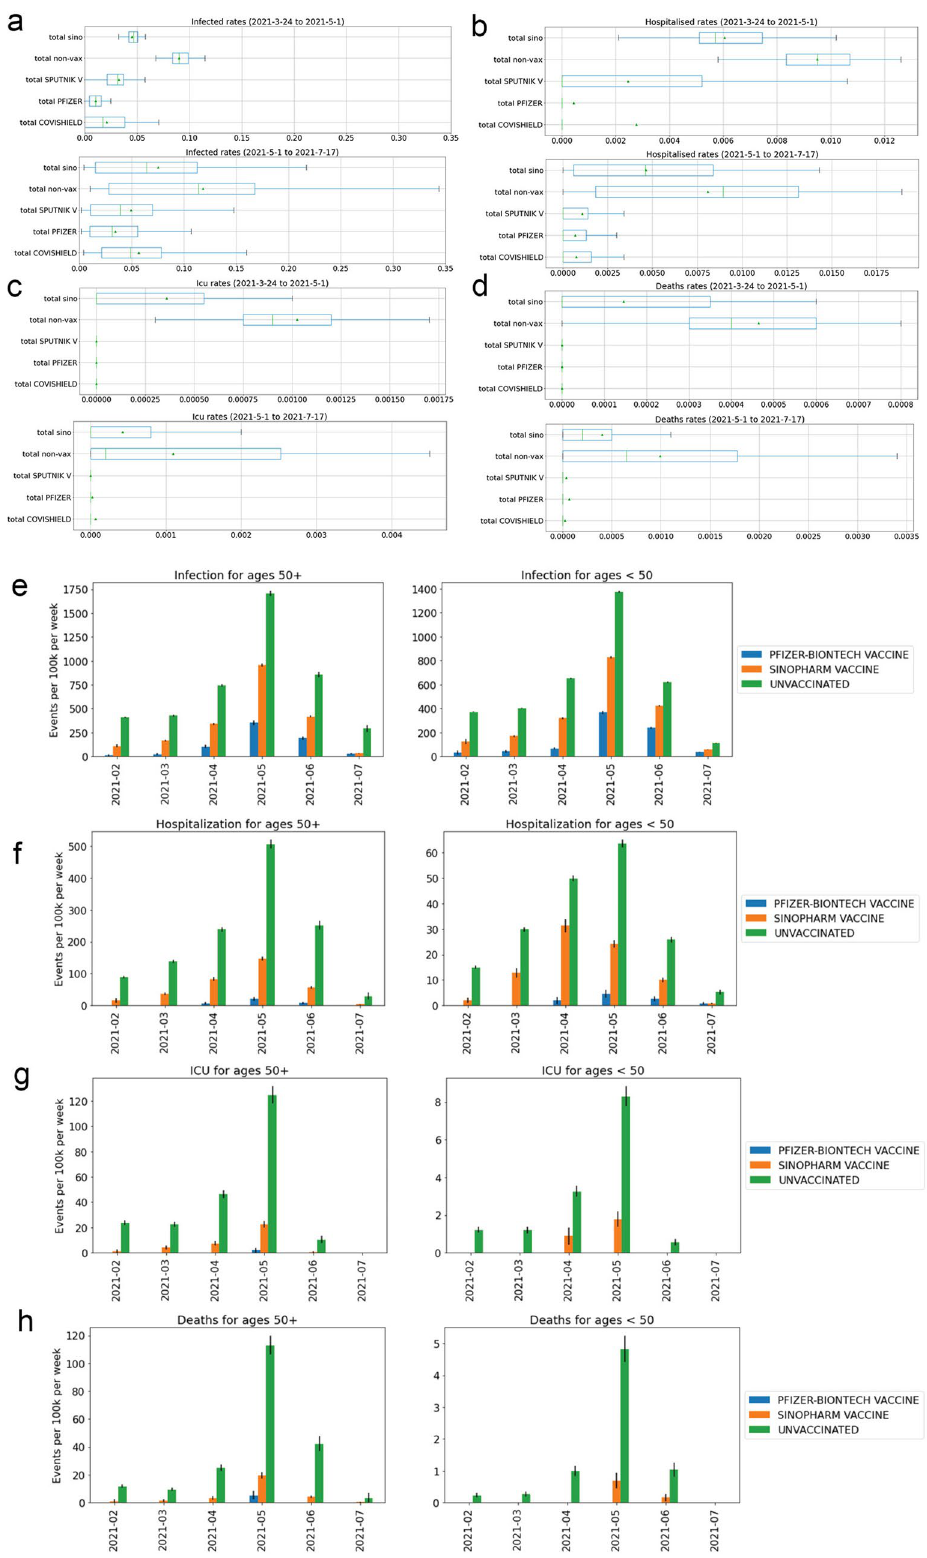
Figure 4. Comparison of infections, hospitalisations, ICU admissions, and deaths. ( a – d ) Box plots illustrating the distribution of rates for infections, hospitalisations, ICU admissions, and deaths. Where there is sufficient data, the whiskers illustrate the maximum and minimum, and boxes encompass the first and third quartiles. The median is displayed as a vertical line in the box. Data are split before and after May 1, 2021 when the Delta variant became prevalent in the studied population. ( e – h ) bar plots representing the events per 100,000 vaccine recipients from February 2021 to July 2021, comparing infections ( e ), hospitalisations ( f ), ICU admissions ( g ) and deaths ( h ). For ( e – h ), breakthrough infections after the Sinopharm and Pfizer vaccine are compared against unvaccinated individuals, divided by age cohorts > 50 years (left plot) and < 50 years (right plot). Standard error is shown as whiskers for each of these plots ( e – h